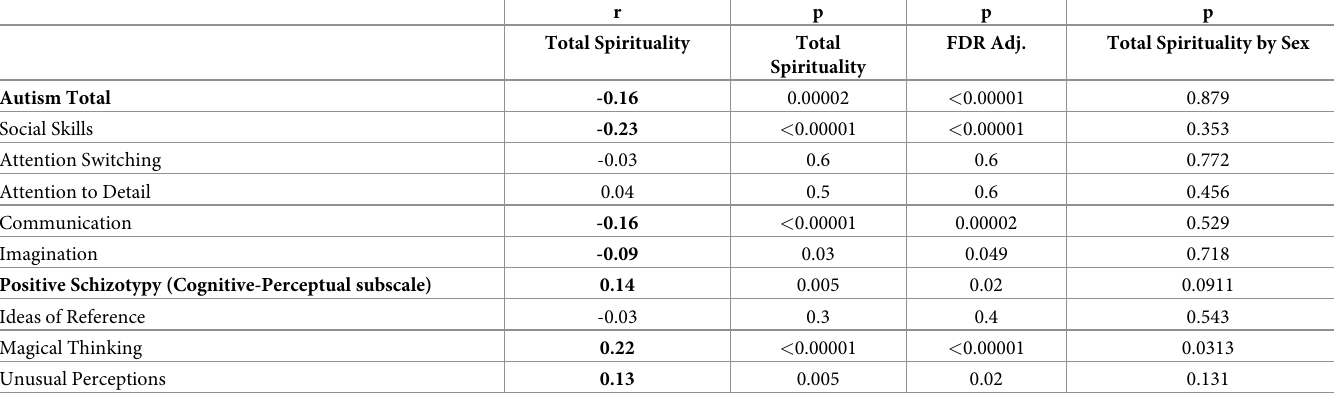
Table 2. Correlations of total spirituality with autism and schizotypal traits, and results from ANCOVAs testing for sex by trait interaction